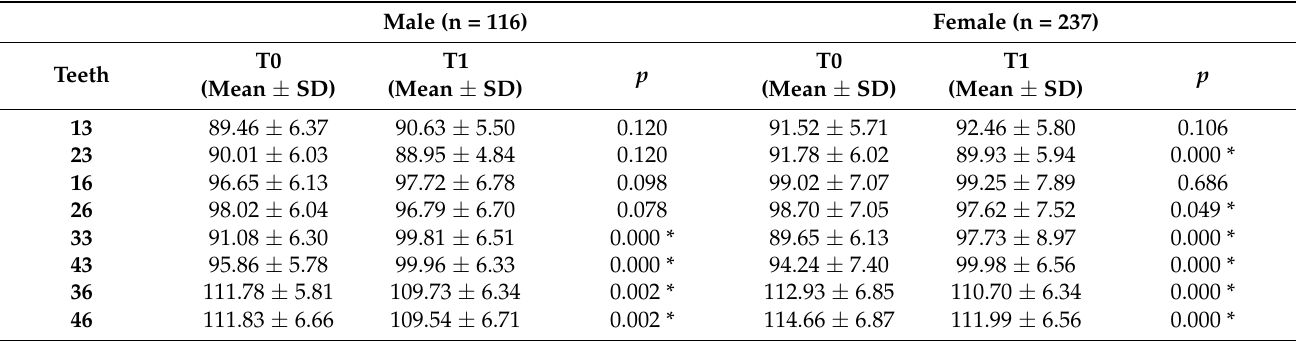
Table 5. Results of T0/T1 angulation changes for gender.